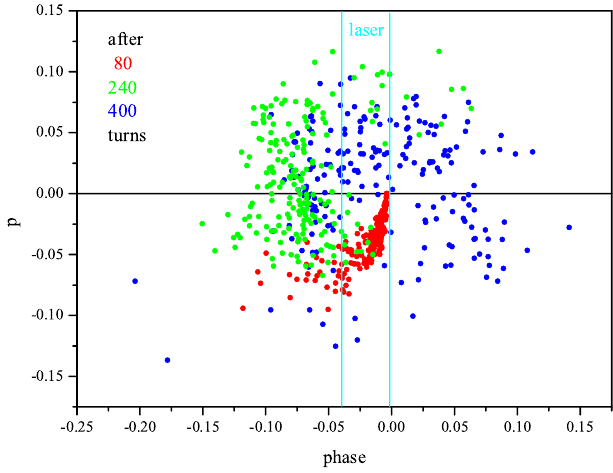
FIG. 10. (Color) Snapshots of macroparticle distributions during the interaction with the laser pulse in the CLIC YAG Compton ring (phase origin at zero of the initial rf